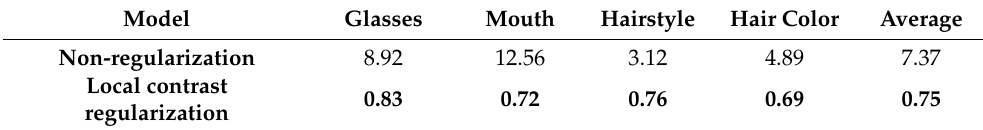
Table 4. PPL scores of FFHQ dataset local Jacobi disentangled method attribute directions ( ↓ ).